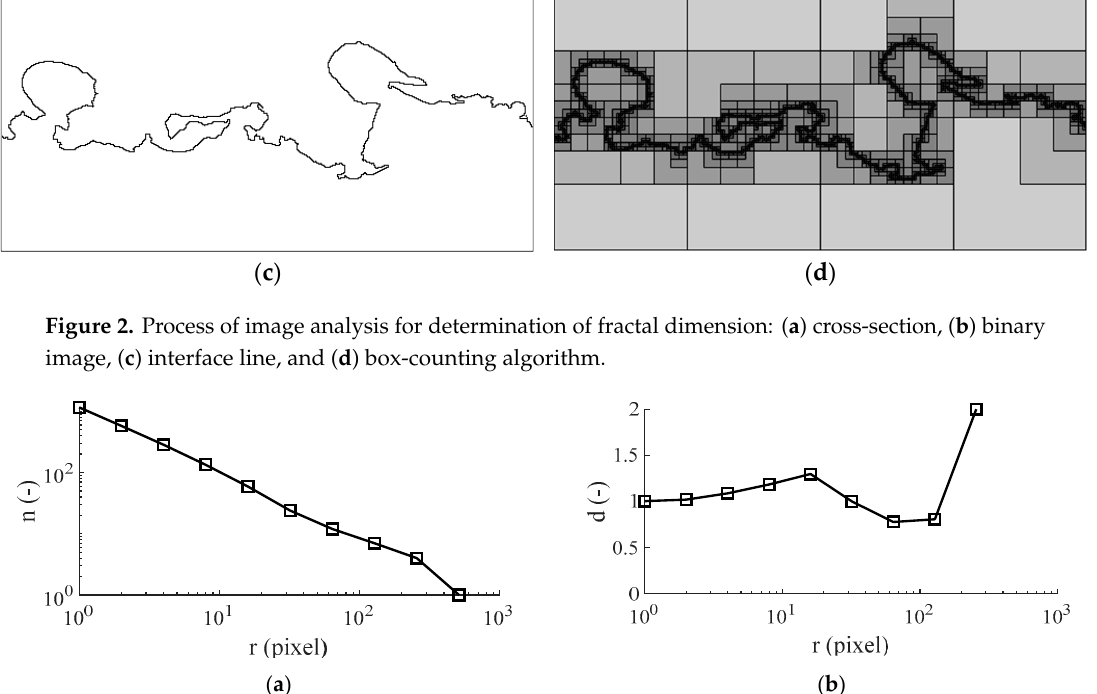
Figure 3. Box-counting: ( a ) number of boxes over box size and ( b ) local dimension over box size.